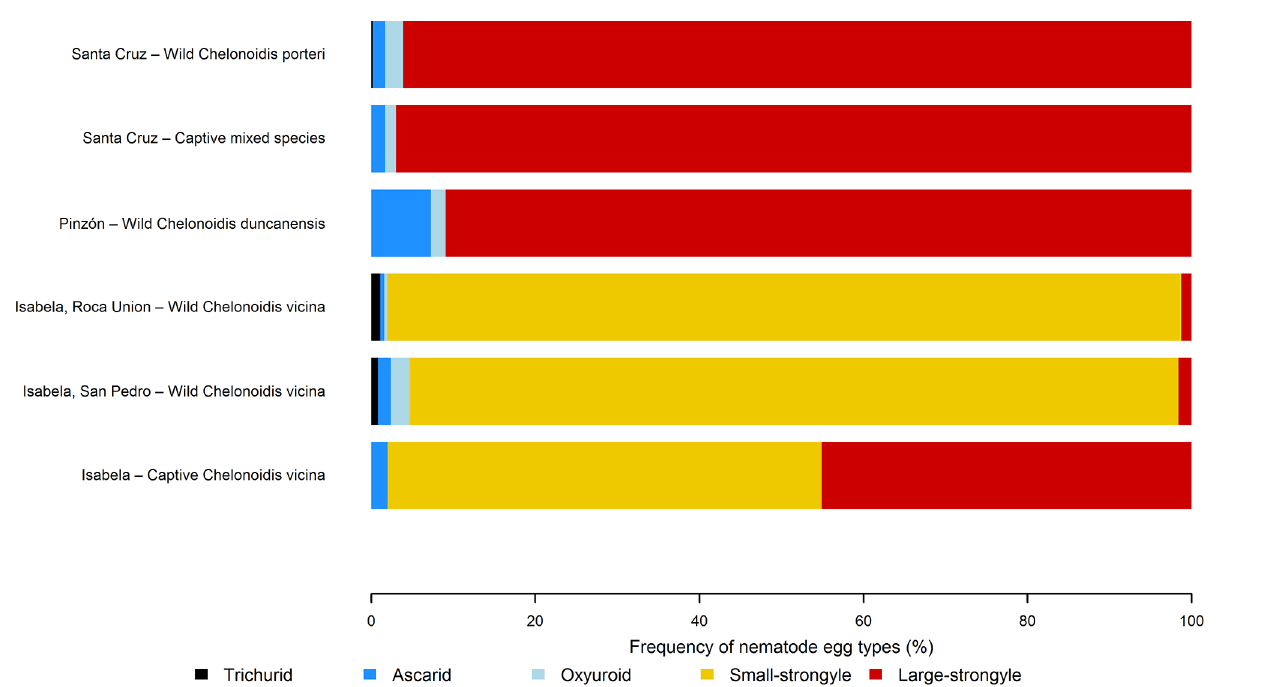
Fig 3. Relative frequency of nematode egg types according to location. Relative frequencies are expressed as a percentage.